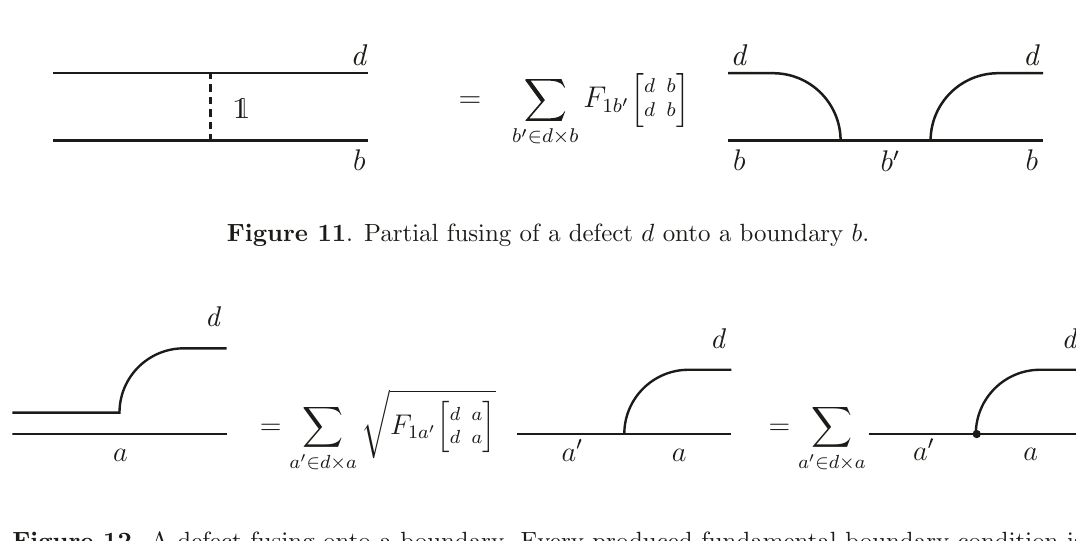
Figure 12 . A defect fusing onto a boundary. Every produced fundamental boundary condition is accompanied by a junction factor which is graphically represented as a thick